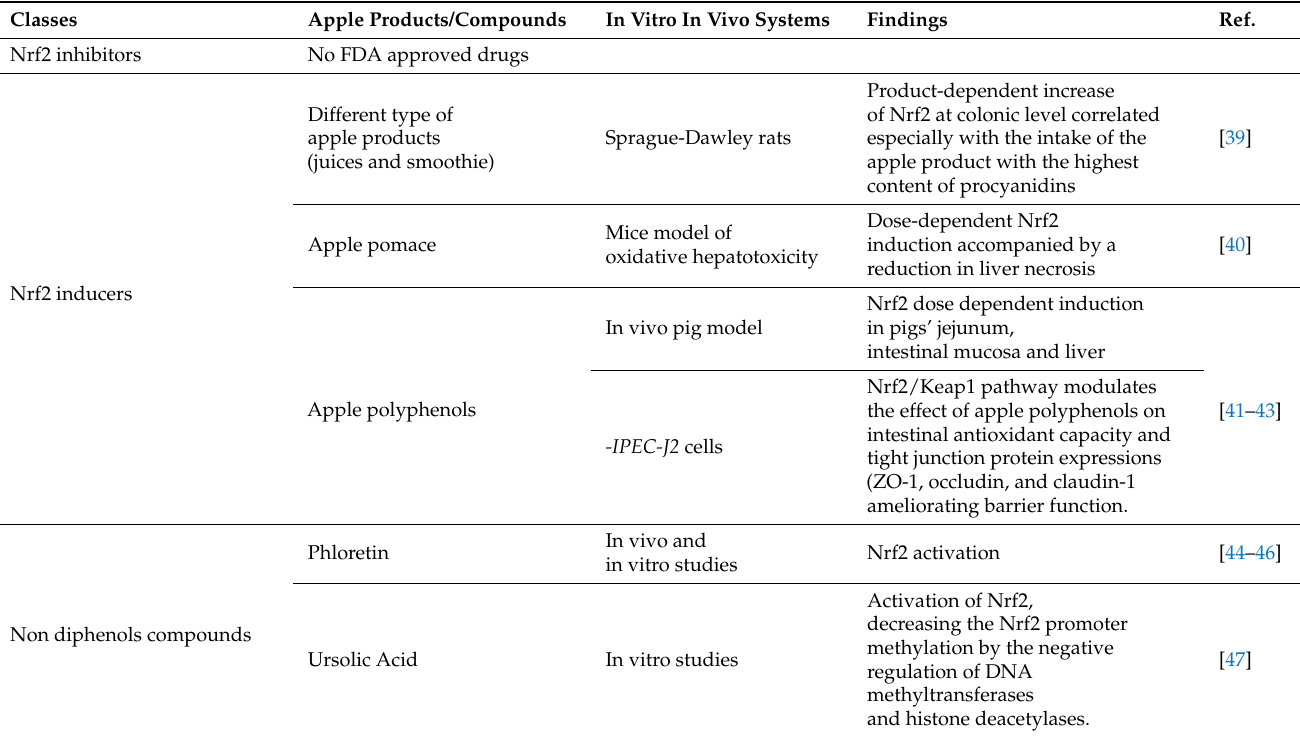
Table 1 summarizes the compounds/classes acting as Nrf2 modulators. Table 1. Summary of the main Nrf2 modulators, the tests performed and results